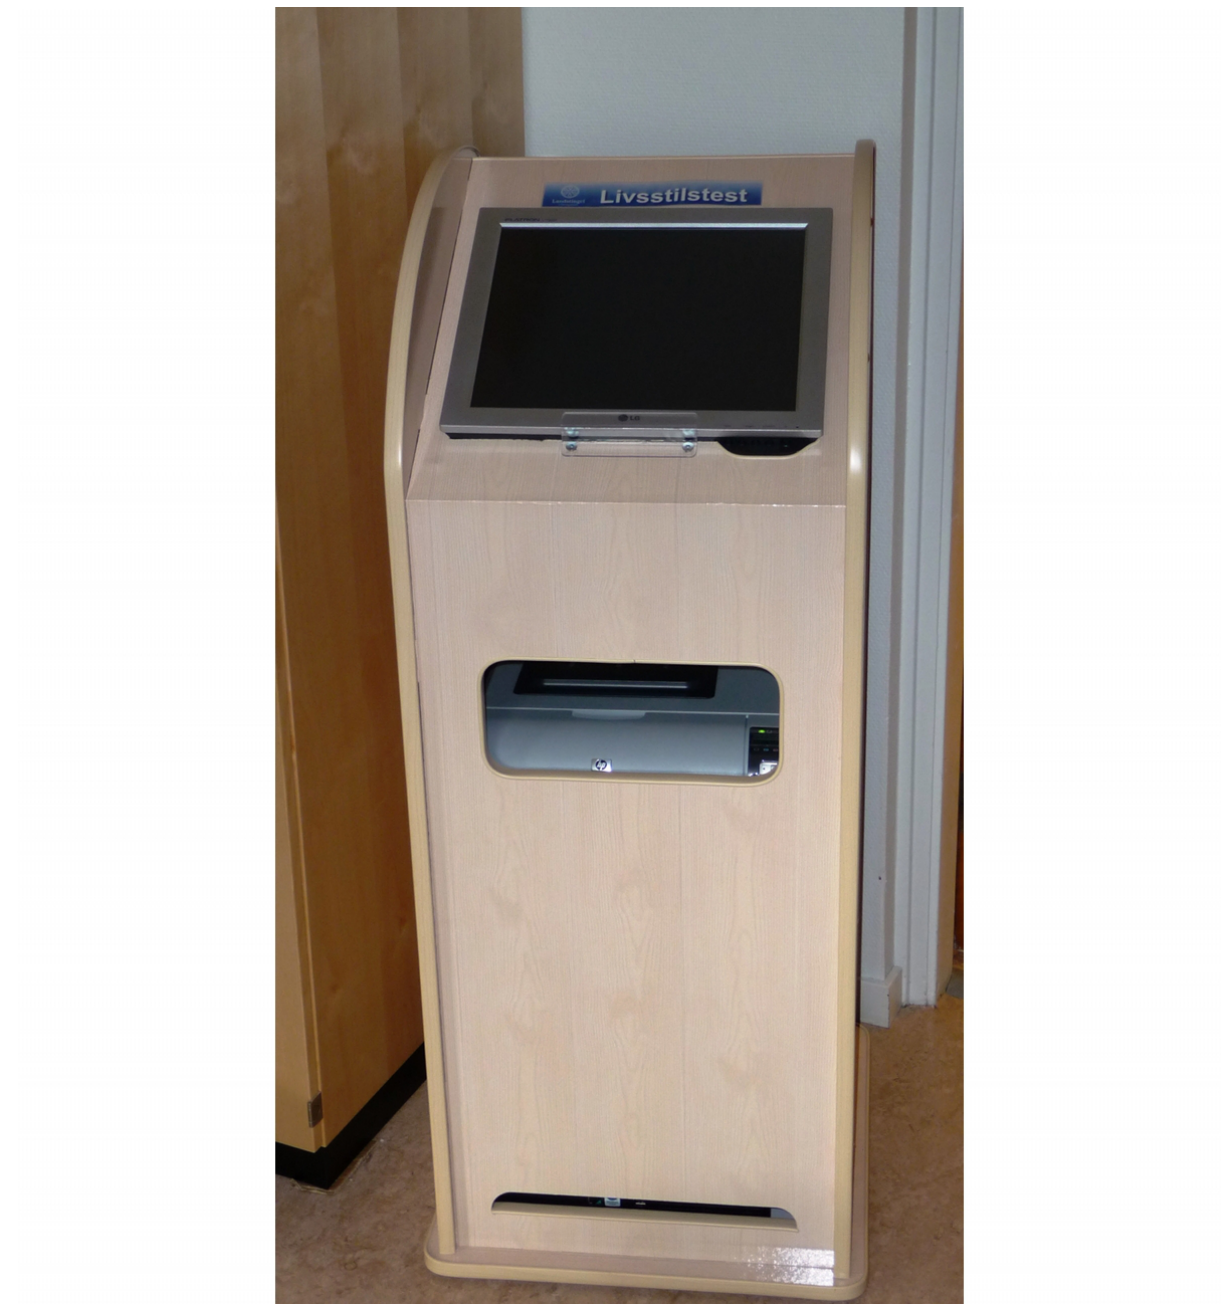
Figure 1. The e-SBI touch screen IT